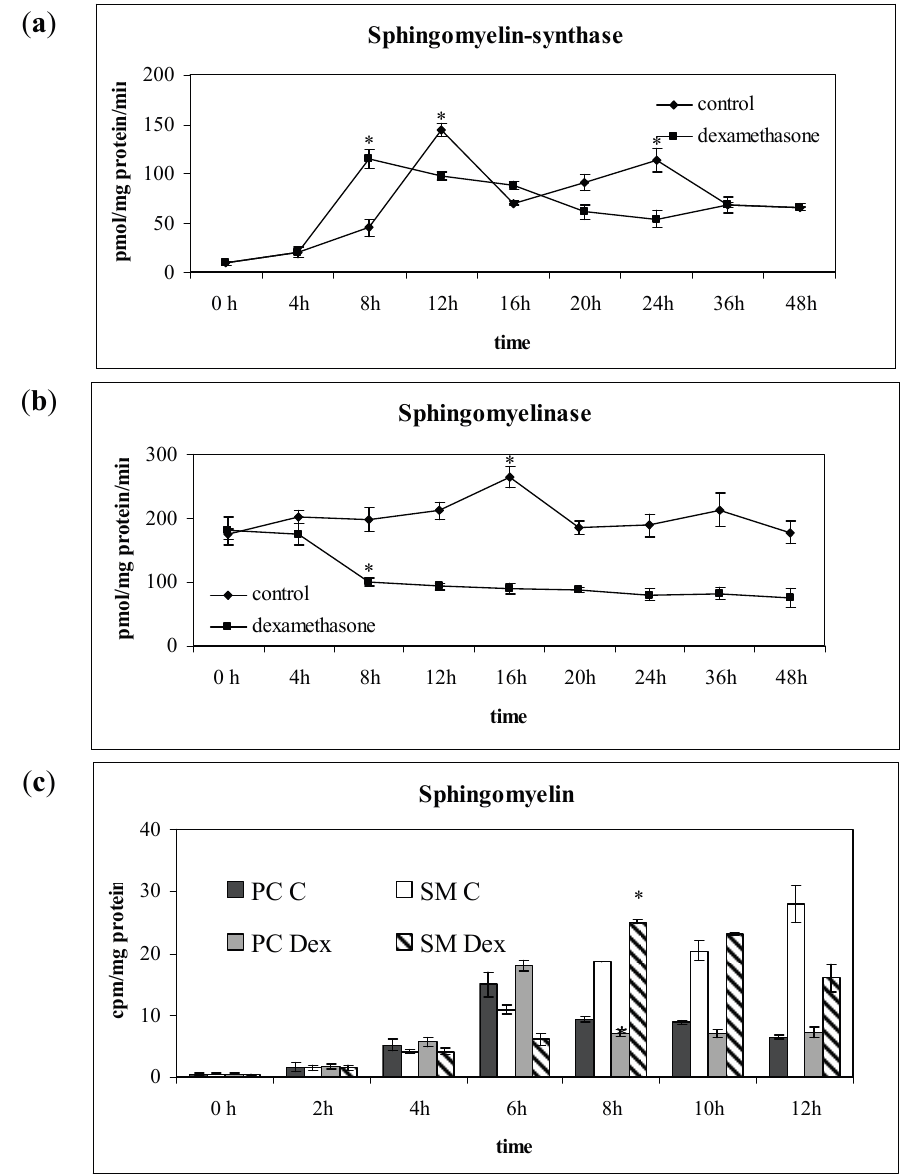
Figure 6. Effect of Dexamethasone on sphingomyelin metabolism in nuclear lipid microdomains (NLMs). Sphingomyelin-synthase ( a ) and Sphingomyelinase ( b ) activity was assayed in NLM purified from SUP-T1 cells cultured in the absence (control) or in presence of Dex for different times up to 24 h. The data were expressed as pmol/mg protein/min and represented the mean ± S.D. of three experiments performed in duplicate. (Significance, * p < 0.001 versus Control sample). Since Dex changed enzyme activities in comparison with control samples at 8 h, 3 H-palmitic acid incorporation in sphingomyelin and phosphatidylcholine ( c ) was evaluated until to 12 h as reported under “Materials and Methods” section. The data are expressed as cpm/mg protein and represent the mean ± S.D. of 3 experiments performed in duplicate. (Significance, * p < 0.001 versus control